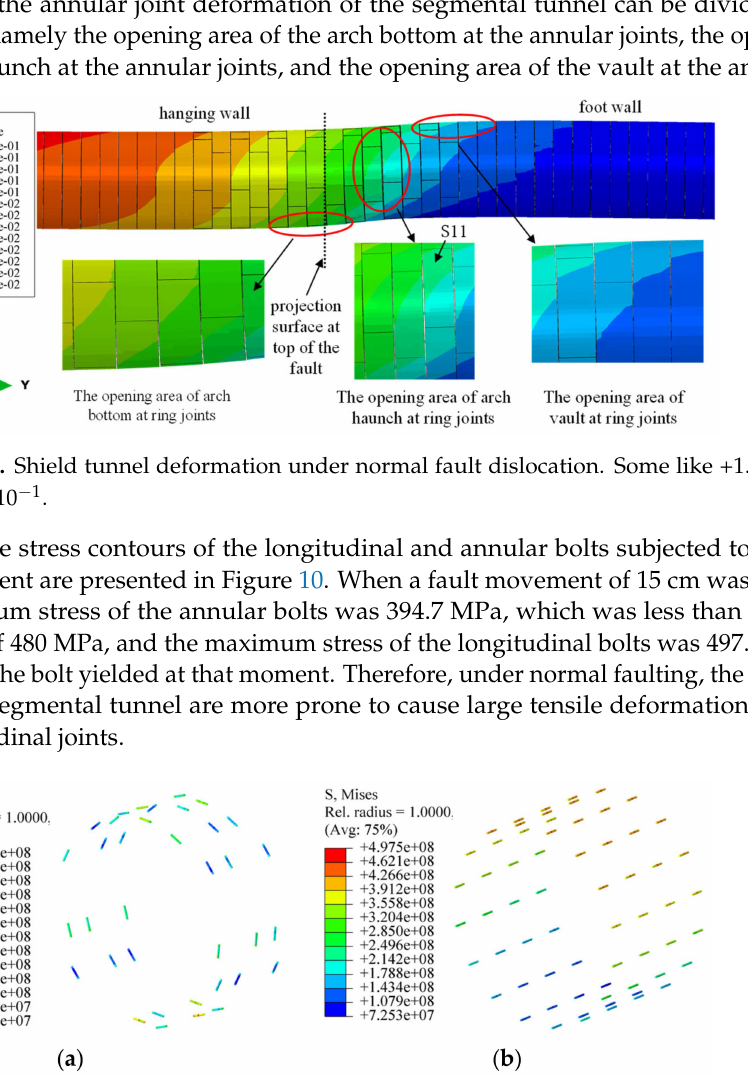
Figure 10. Stress of the joint bolts subjected to normal fault dislocation: ( a ) stress of circumferential bolts and ( b ) stress of circumferential bolts. Some like +3.947e+08 means 3.947 × 10 8